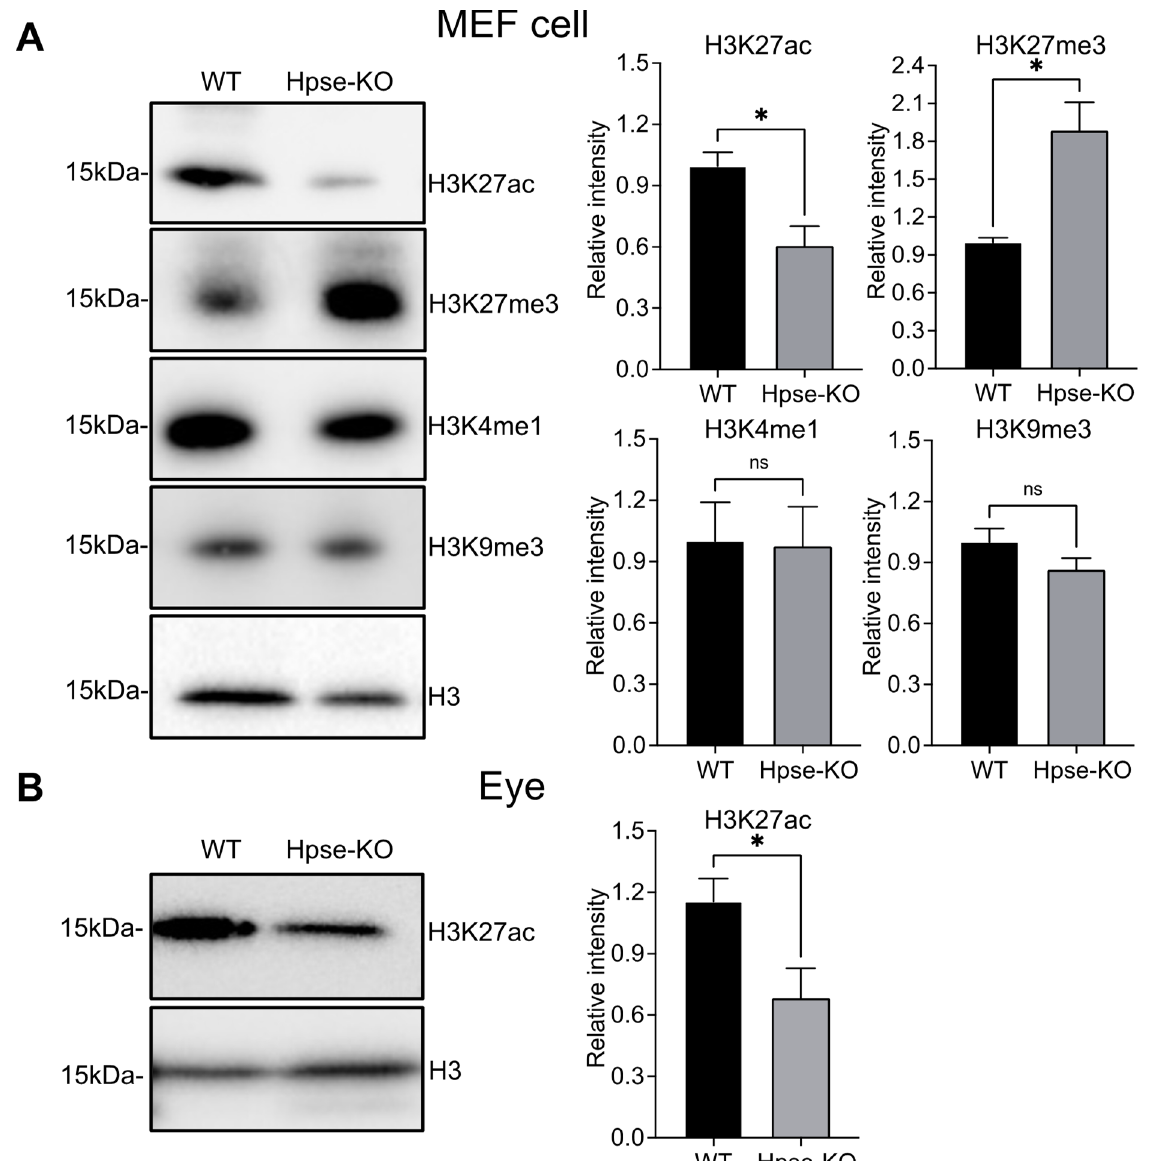
Figure 4. Assessment of H3K levels in cells and organs by Western blot analysis. ( A ) Cell lysates of 20 µ g total protein were separated by SDS-PAGE and probed with specific antibodies against H3K27ac, H3K27me3, H3K4me1, and H3K9me3. Intensity of the bands was quantified by the Image Lab software (Bio-Rad). H3 is used as loading control. ( B ) Protein levels of H3K27ac in the eyes of adult mice analyzed by the same method using anti-H3K27ac antibody. A representative blot is shown. The graphs show the mean ± SEM of band intensity (WT is set as 1). Relative expression related to WT is shown *: p < 0.05; ns = no significant difference. The data were from three independent cultures; the samples of eyes were collected from 6 mice per